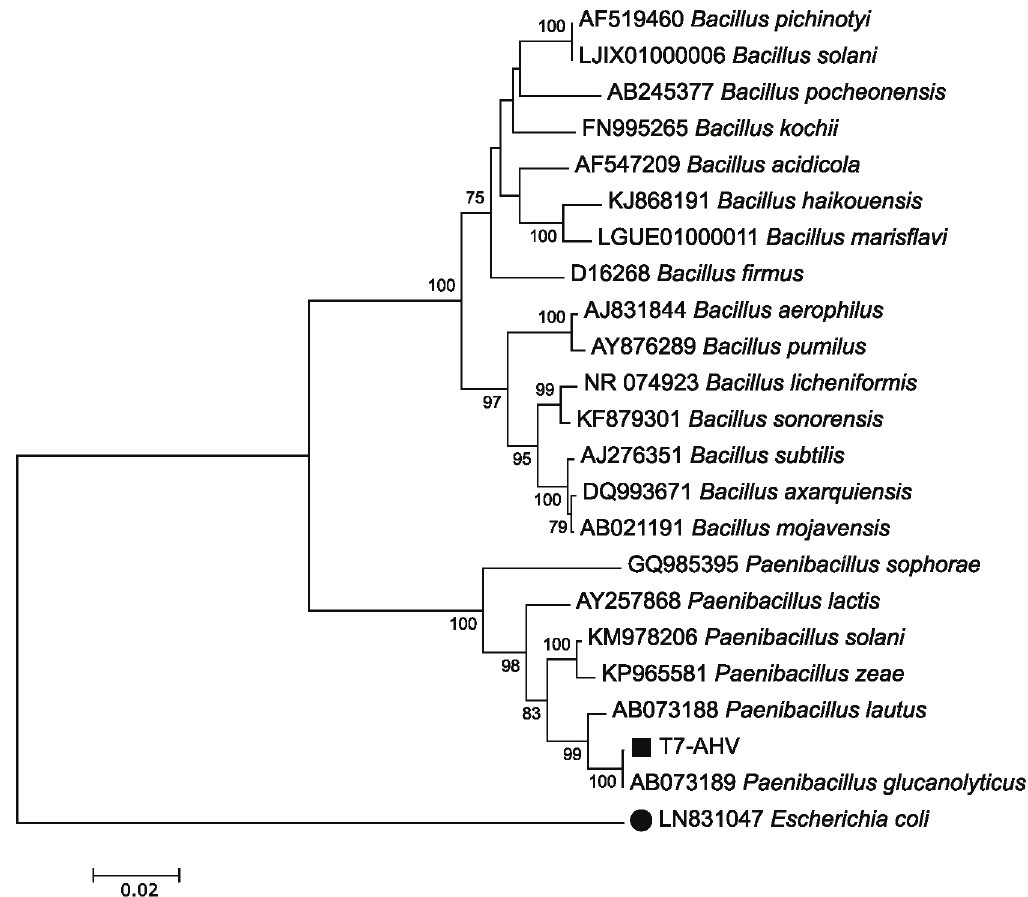
Fig. 1 – 16s rRNA sequences phylogenetic tree. Only the bootstrap values above 70 % are shown. The 16S rRNA gene fragment of Escherichia coli was used as outgroup.